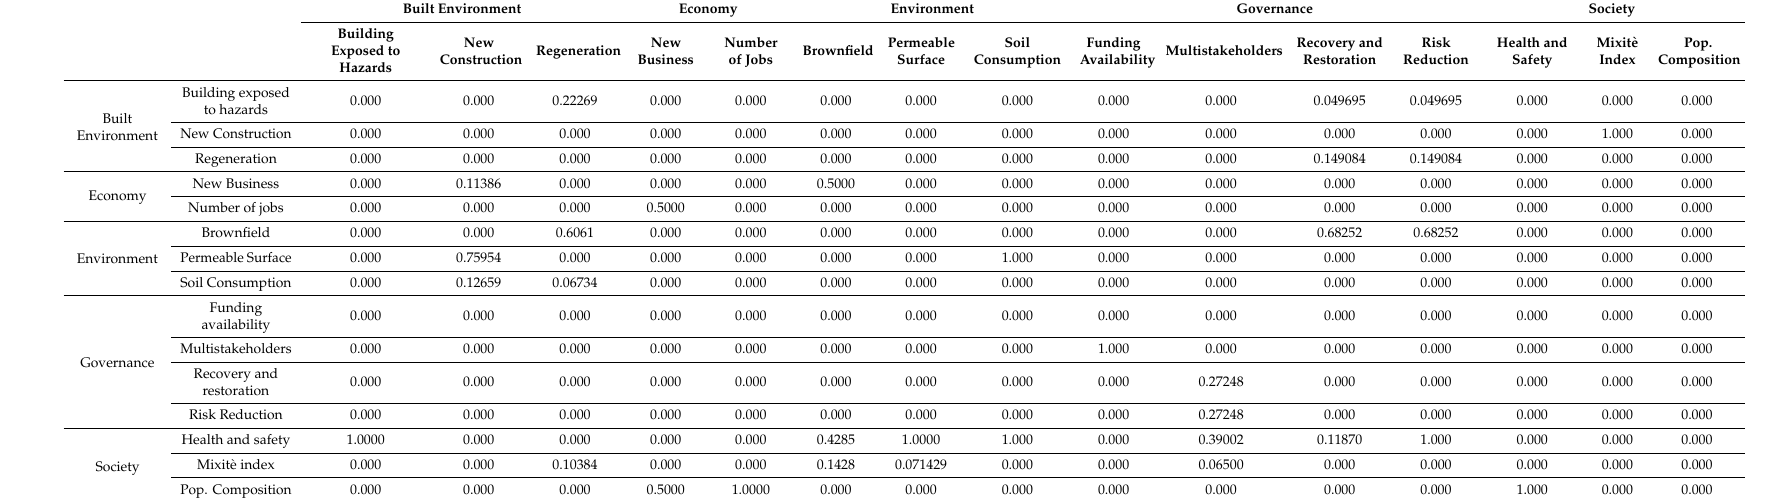
Table A3. Weighted Super